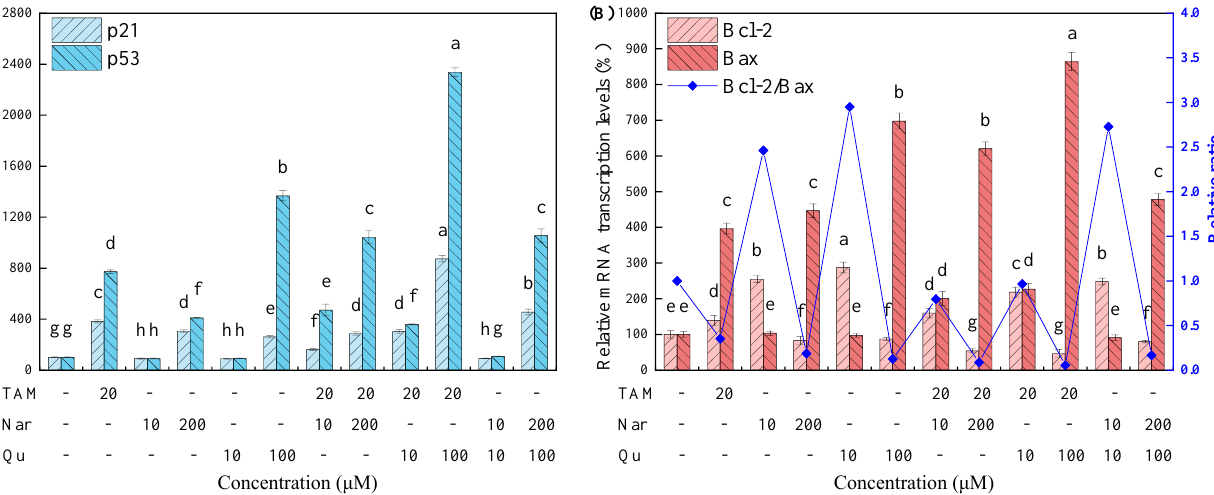
Figure 7. Tamoxifen, naringenin and quercetin regulated the mRNA transcription of the typical apoptosis-related genes in HepG2 cells. ( A ) The mRNA transcription levels of p21 and p53. ( B ) The mRNA transcription levels of Bcl-2 and Bax along with Bcl-2/Bax ratios. Results are expressed as mean ± SD of three independent experiments ( n = 3). a–h : Different letters indicate significant differences ( p < 0.05) in cell apoptosis for 24 h.